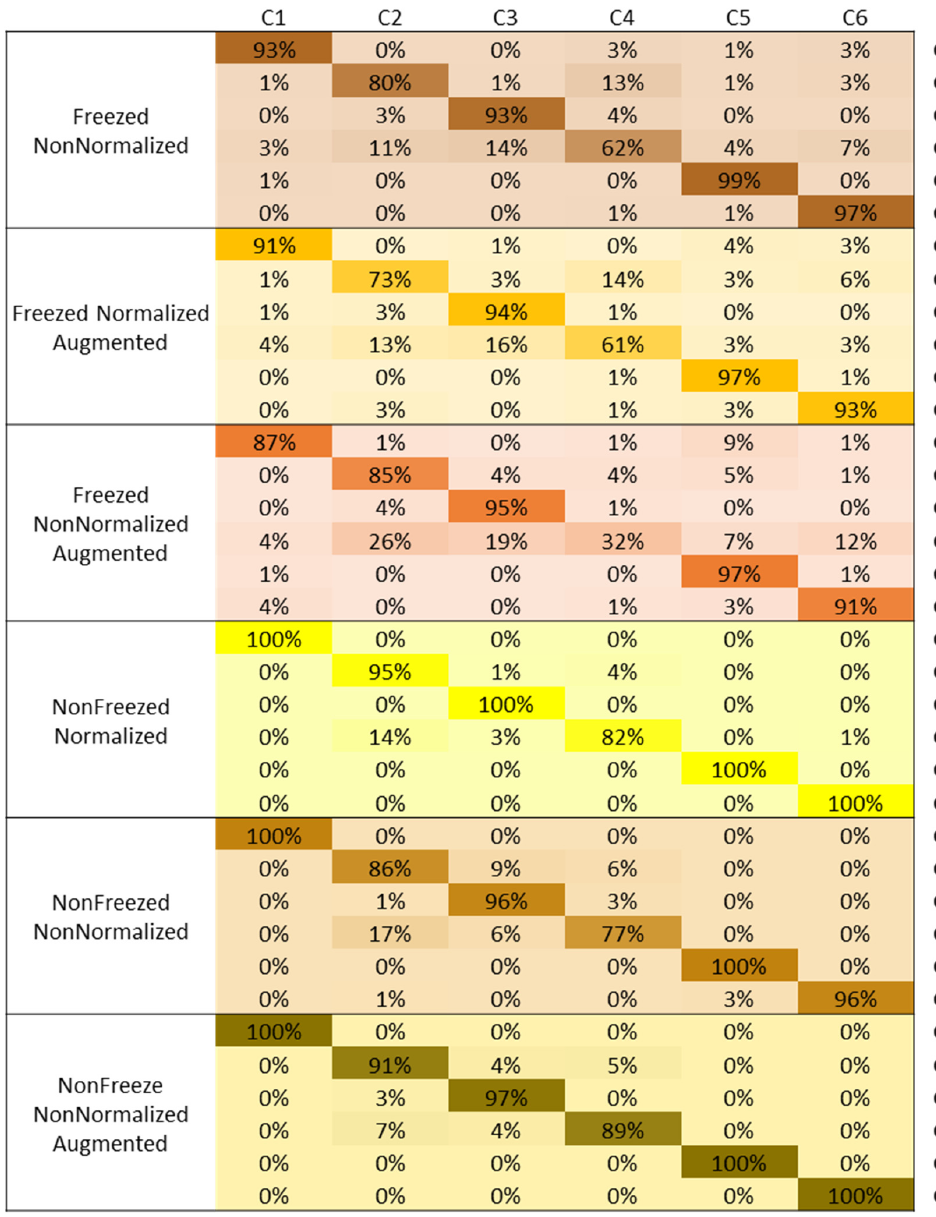
Figure 7. Confusion Matrix based comparison for different rice diseases identification for VGG19 with different model setups.